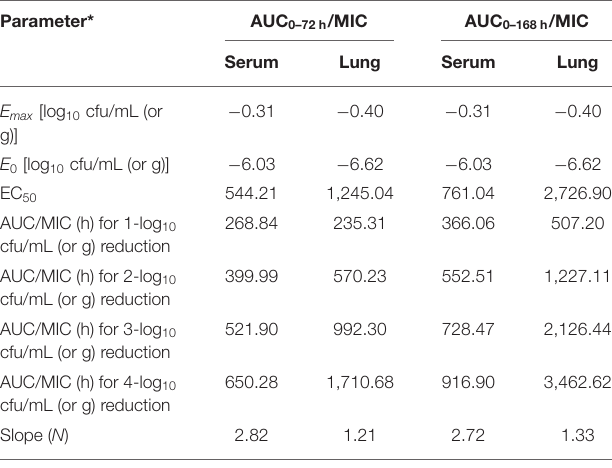
TABLE 3 | Pharmacodynamic analysis of tulathromycin in a H. parasuis intraperitoneal infection model. Parameter* AUC 0–72h /MIC AUC 0–168h